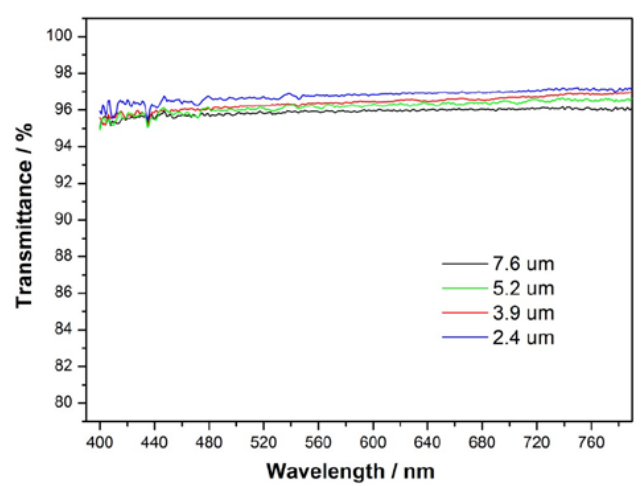
Figure 5. Light transmission of the PFMA dielectric layer with different thickness.